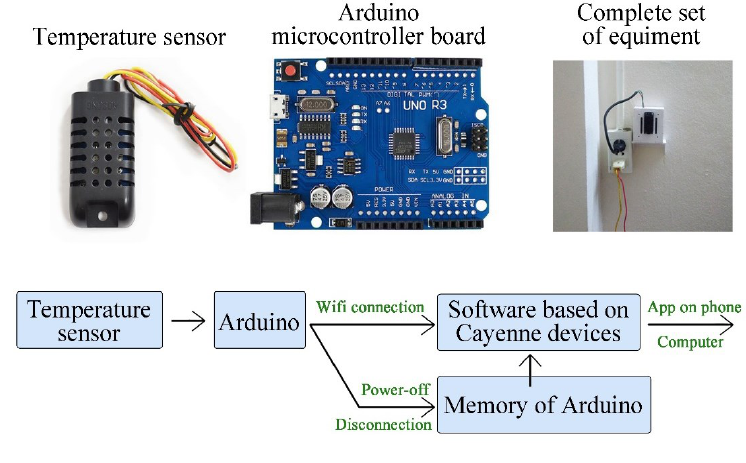
Figure 7. Instrumentation and their principle of